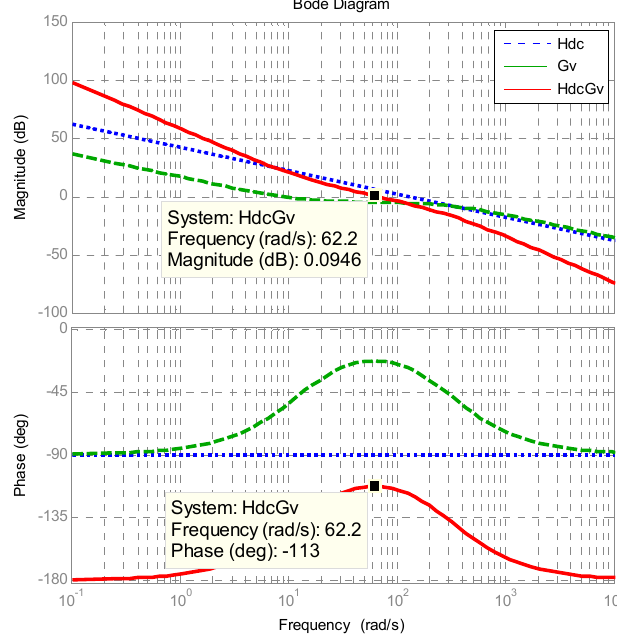
Figure 7. Bode plot of shunt APF inductor DC link voltage control loop.